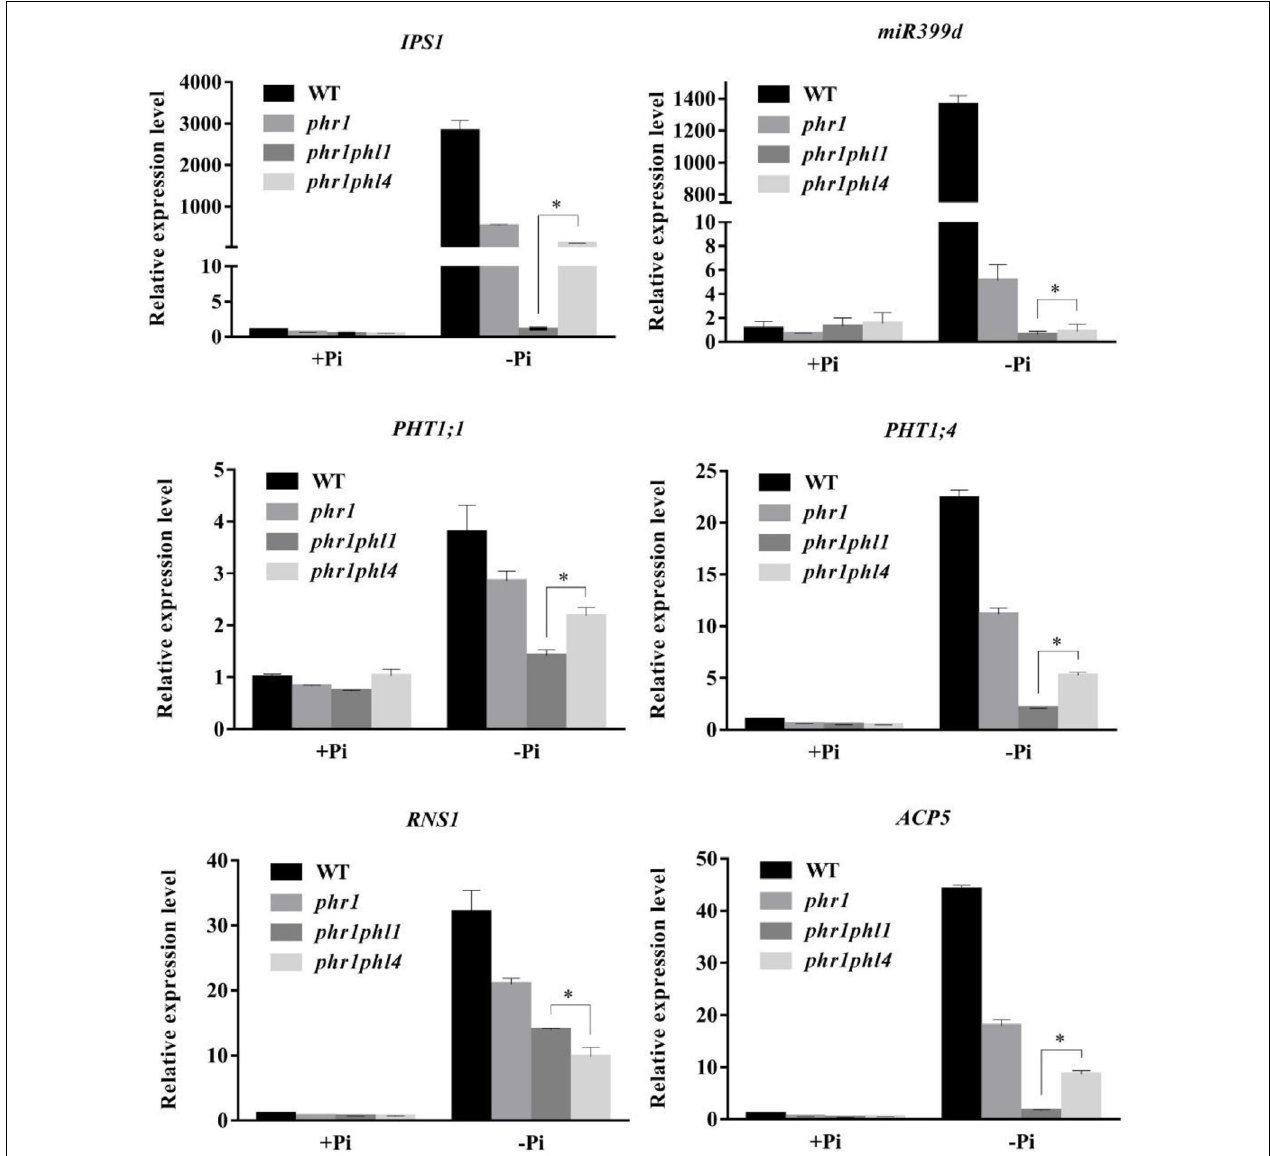
FIGURE 8 | Analysis of PSI gene expression in the WT, phr1 , phr1phl1 , and phr1phl4 . Roots of 8-day-old seedlings of the WT and other mutants grown on +Pi and –Pi media were used for qPCR analysis. The names of the genes examined are indicated on the top of each panel. Values are the means ± SD of three biological replicates and represent fold changes normalized to transcript levels of the WT on +Pi medium. Means with asterisks and thin lines are significantly different from each other ( P < 0.05, t -test).